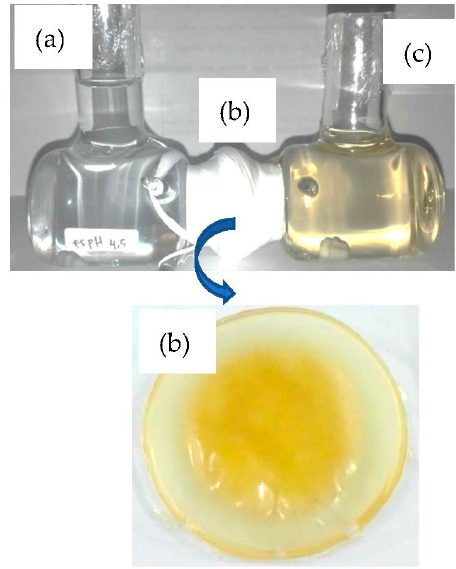
Figure 1. The PIMs installed between the two chambers: ( a ) source phase; ( b ) PIM membrane; ( c ) receiving phase.